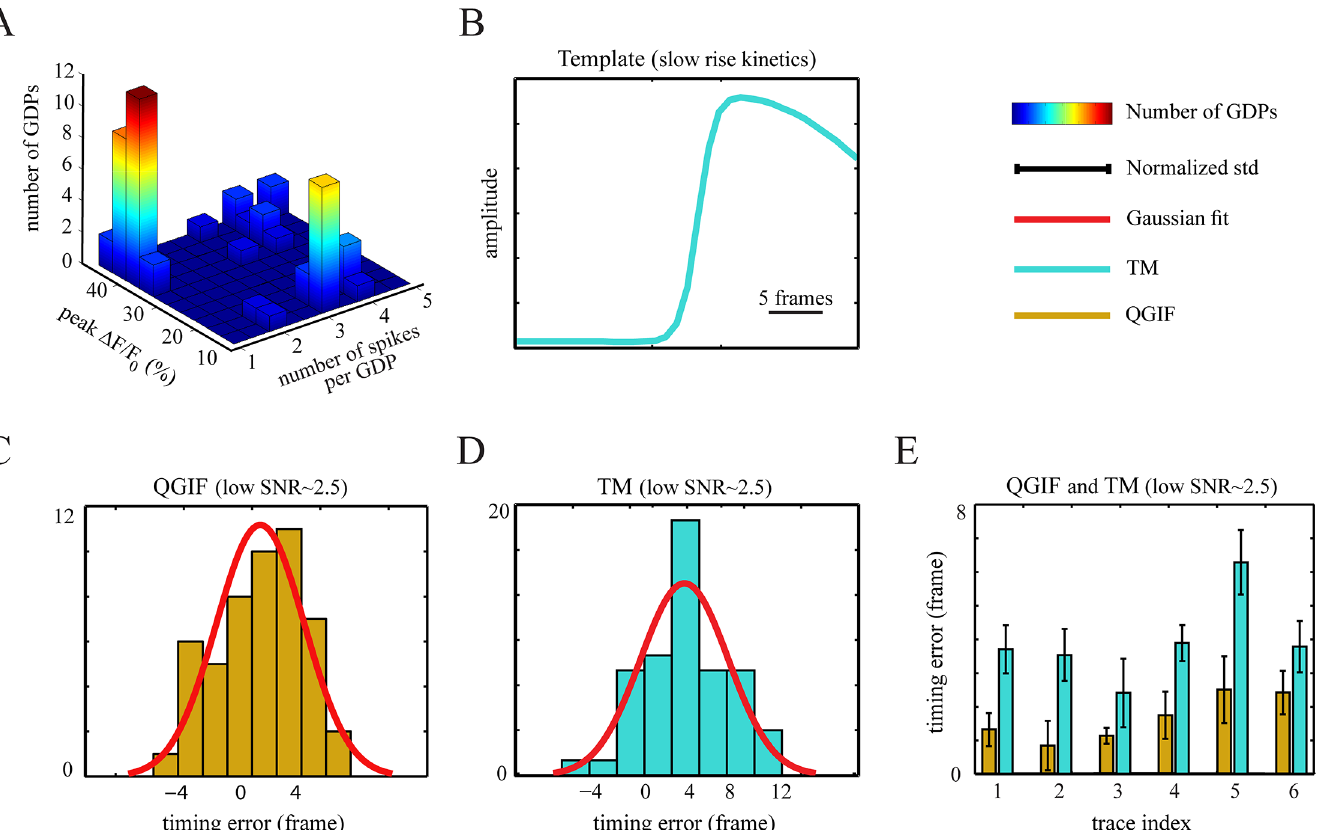
Fig 8. Accuracy of the reconstructed GDP onset times of the proposed approach and template matching method on in vitro data. ( A ) The 3D histogram shows the relation between the number of spikes per spontaneous GDPs and the peak of the fluorescence transients (n = 51 GDPs). ( B ) The two- term Boltzmann template for the template matching (TM) method derived from the first experimental data set. ( C ) Timing error distributions computed for the QGIF model inversion for all six fluorescence traces, under low SNR. Gaussian fit: mean = 1.7 and std = 3.2 time bins (i.e. frames). ( D ) Timing error distribution for the TM method, under low SNR. Gaussian fit: mean = 3.7 and std = 3.8 time bins. ( E ) Timing errors estimated by the QGIF model and the TM method plotted for each in vitro trace of the first data set.